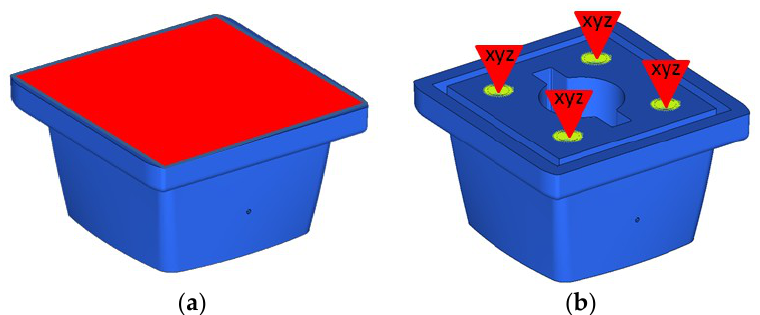
Figure 8. Case study part (support, in blue) and membrane (in yellow): ( a ) Surface (red) including a restriction; and ( b ) four screw fasteners support (yellow), which are the points at where the model does not allow any physical displacement over any of the cartesian directions (X-Y-Z).